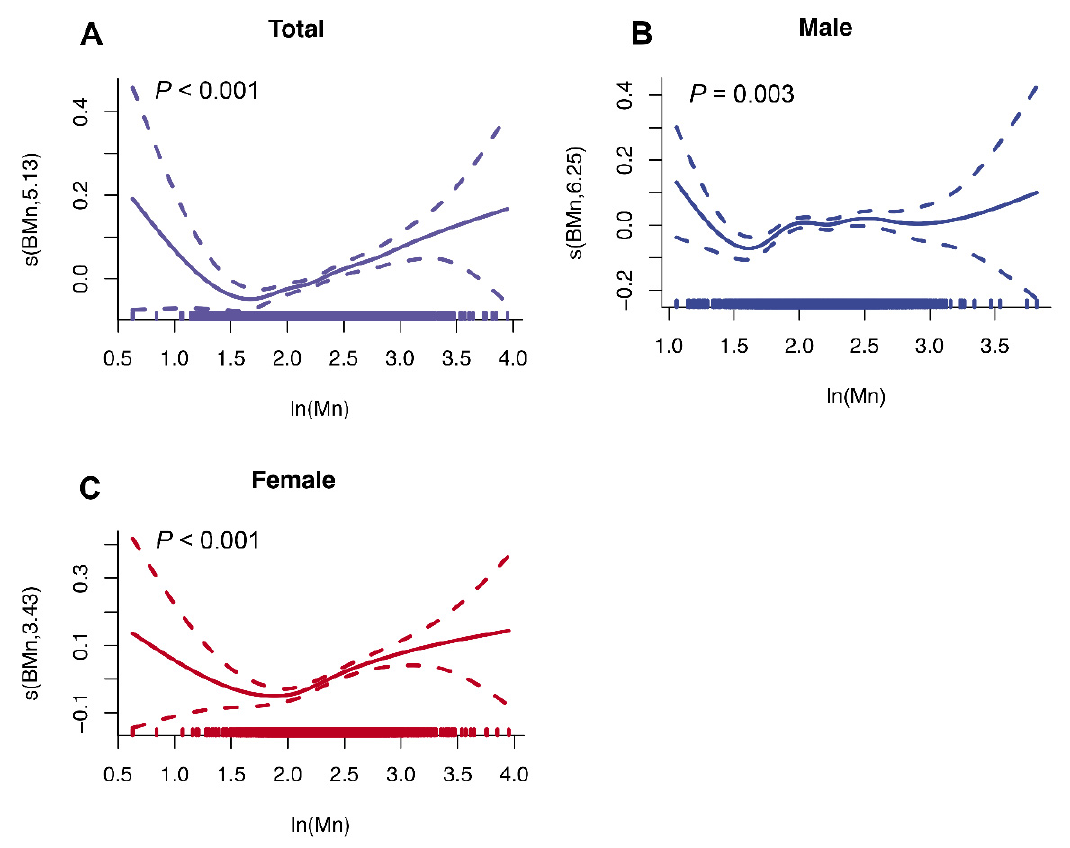
Figure 2. Non-linear associations between blood Mn levels and VAT mass using generalized additive model (GAM): ( A ) Dose–response association between blood Mn levels and VAT mass in the total dataset. ( B ) Dose–response association between blood Mn levels and VAT mass in the male subpopulation. ( C ) Dose–response association between blood Mn levels and VAT mass in the female subpopulation. Models were adjusted for gender (only in total), age, race, educational level, BMI, marital status, PIR, smoking status, 24 h alcohol consumption, physical activity, 24 h energy intake, and 24 h fat intake.